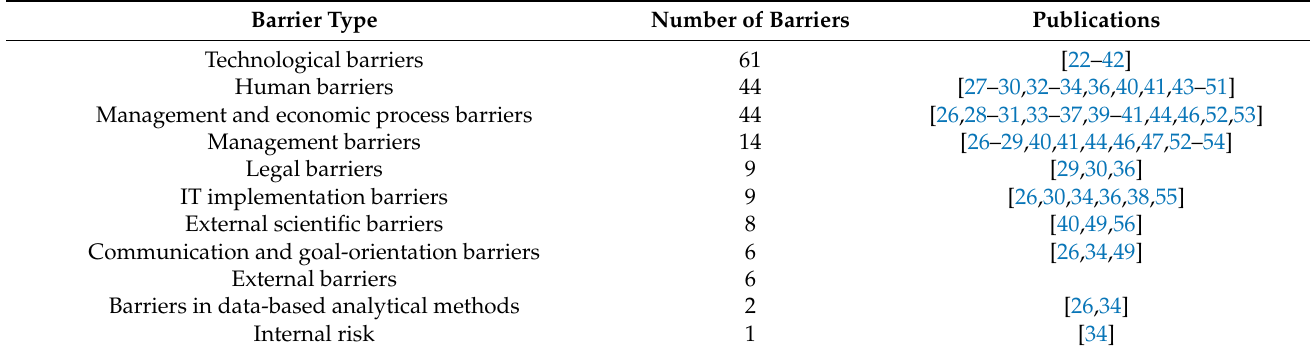
Table 2. Most commonly stated barriers in supply chain company